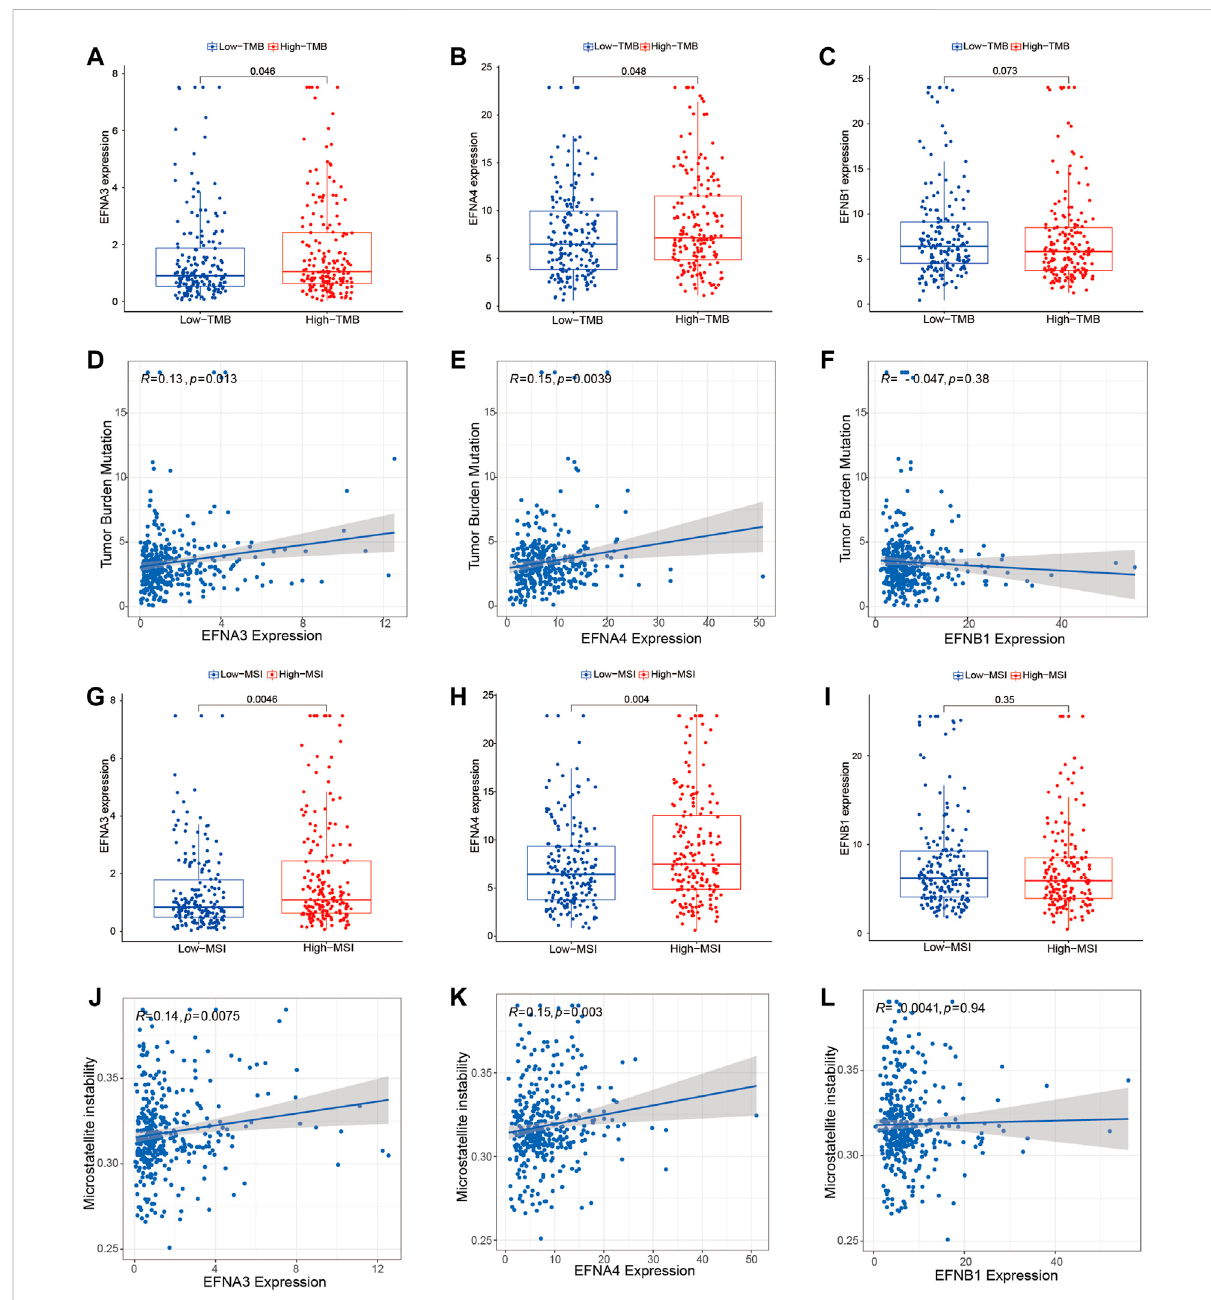
FIGURE 9 Association of prognosis-related ephrins with tumor mutation burden (TMB) and microsatellite instability (MSI) in HCC. (A – C) The differential expression of EFNA3, EFNA4, and EFNB1 in the low- and high-TMB groups. (D – F) Scatterplots displaying the association between TMB scores and EFNA3expression (D) ,EFNA4expression (E) ,andEFNB1expression (F) . (G – I) ThedifferentialexpressionofEFNA3,EFNA4,andEFNB1inthelow-and high-MSI groups. (J – L) Scatterplots displaying the association between MSI scores and EFNA3 expression (J) , EFNA4 expression (K) , and EFNB1 expression (L) . r: Spearman ’ s rank coef fi